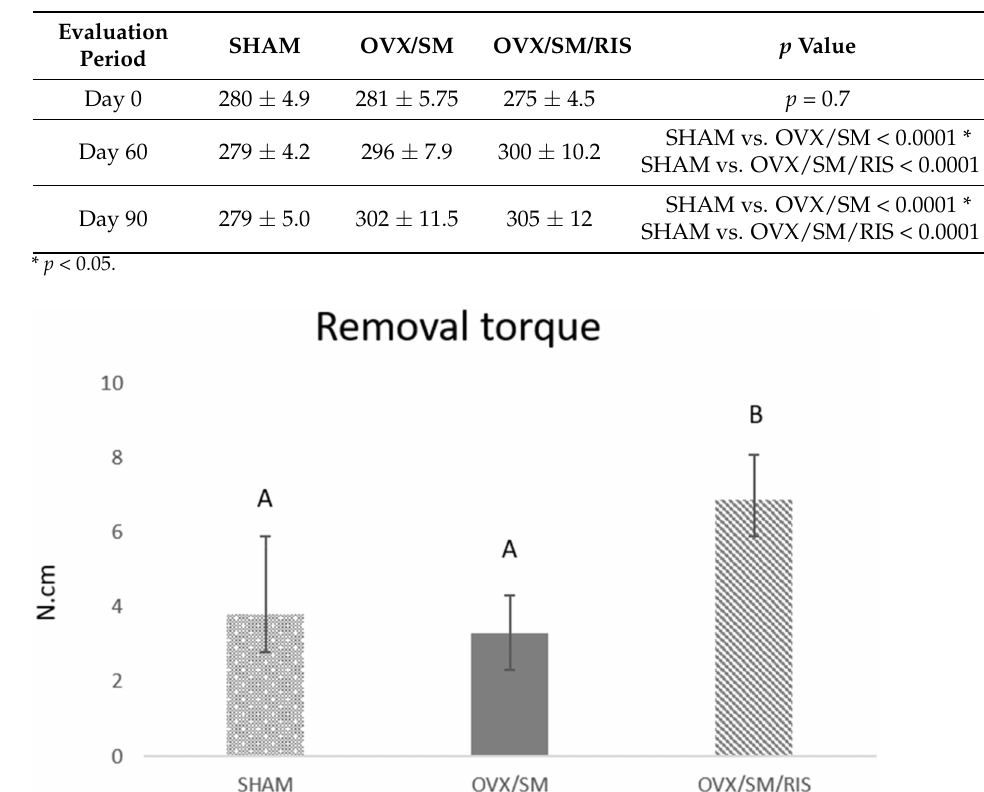
Figure 4. Removal torque values of SHAM, OVX/SM, and OVX/SM/RIS groups in N.cm. Different letters in the columns indicate statistical difference ( p < 0.05,